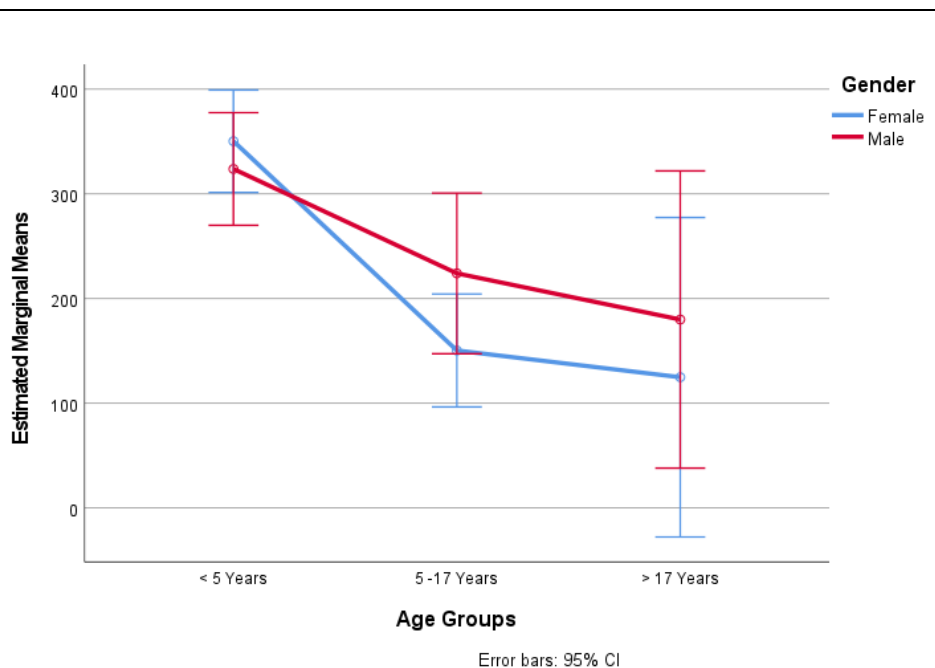
Figure 3. Estimated marginal mean strongyle egg counts during different seasons in horses in Ire- land. The highest mean strongyle egg count was recorded in winter (305 EPG, S.E. = 29.27) when a high percentage of animals (33.8%) shed > 500 strongyle EPG. The lowest mean egg counts occurred in spring (146 EPG, S.E. = 46.80). The results highlighted that the dif- ferences in the mean strongyles EPG for winter and spring were statistically significant ( p